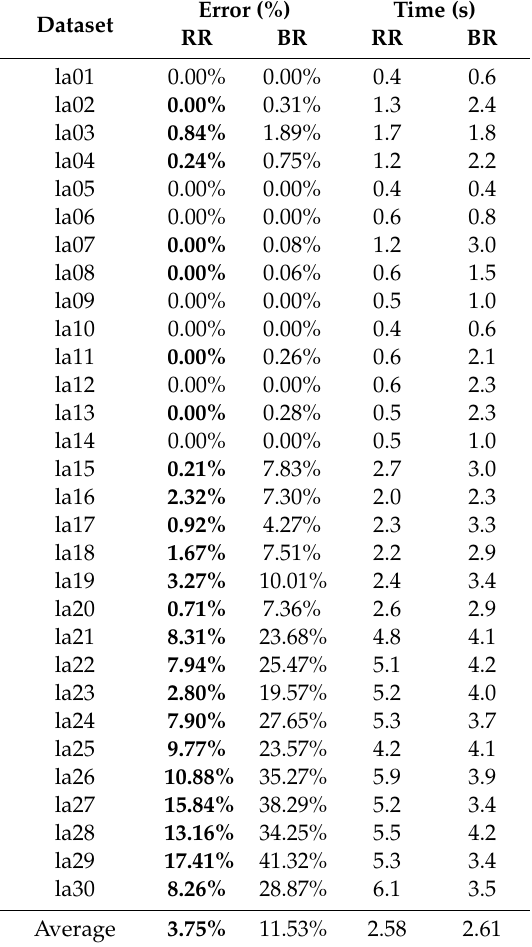
Table 3. Mean errors (%) and computations times (s) obtained for the analyzed job-shop scheduling (JSSP) datasets solved with di ff erent sets of